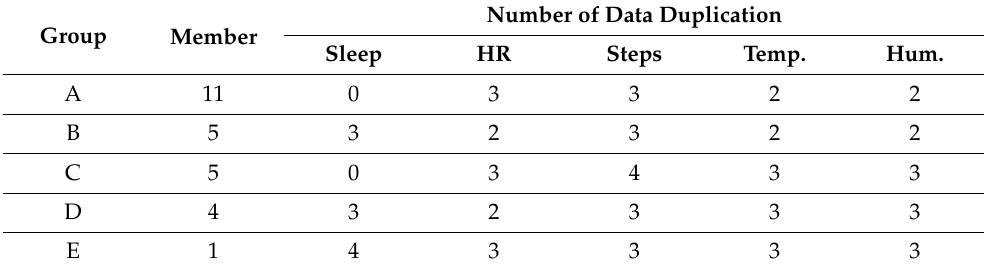
Table 2. Data duplication count by device type.